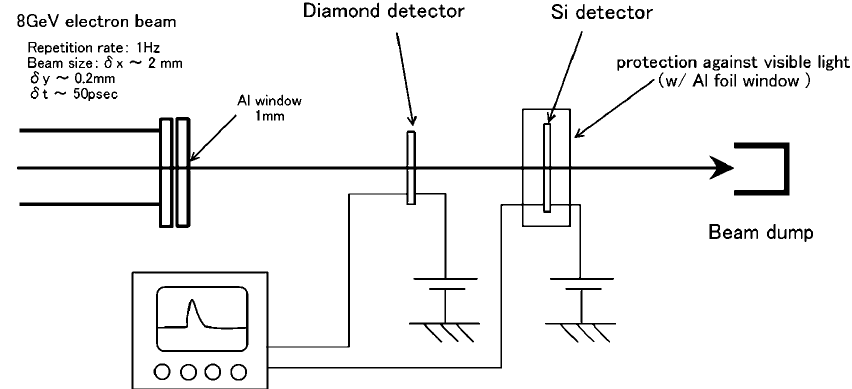
FIG. 3. Setup of the electron beam tests performed in the SPring-8 synchrotron beam dump area.